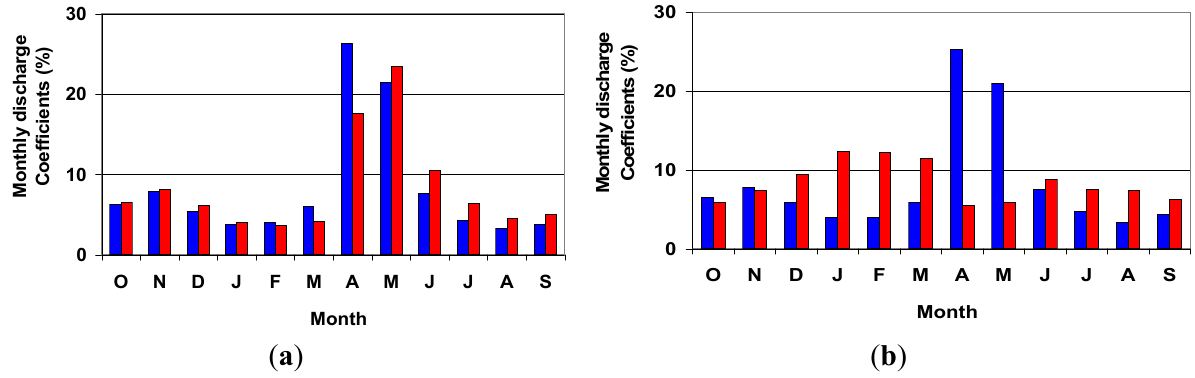
Figure 2. ( a ) Comparison of monthly discharge coefficients in natural rivers: L’Assomption River (blue bars) and Matawin River upstream from the Matawin dam (red bars); ( b ) comparison of monthly discharge coefficients in regulated rivers: Ouareau River downstream from the Rawdon dam (blue bars) and Matawin River downstream from the Matawin dam (red